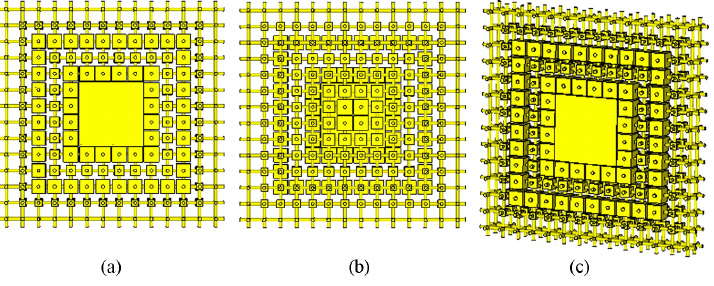
Figure 5. Two-layer lattice block expansion structure: ( a ) top view, ( b ) bottom view, and ( c ) side